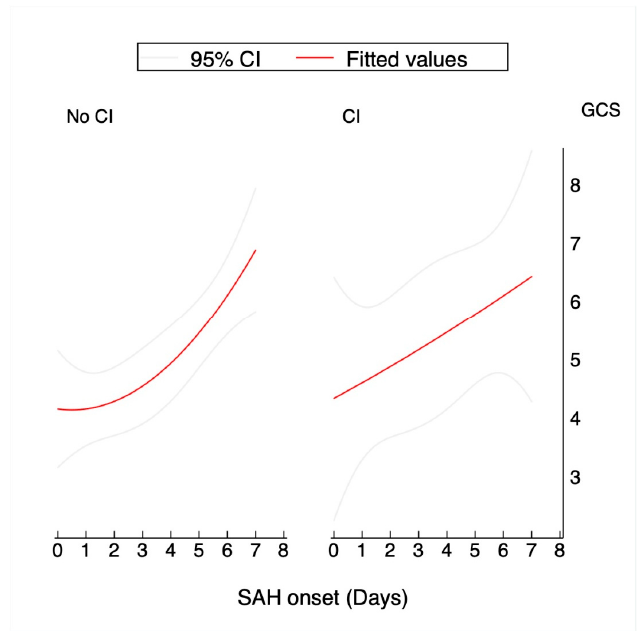
Figure 3. Graphic illustration of the prediction of the mean Glasgow Coma Scale (GCS) (read lines) during the first week: a comparison of CI and non-CI patients. The gray lines represent the confi- dence interval (95%) of the predicted mean.